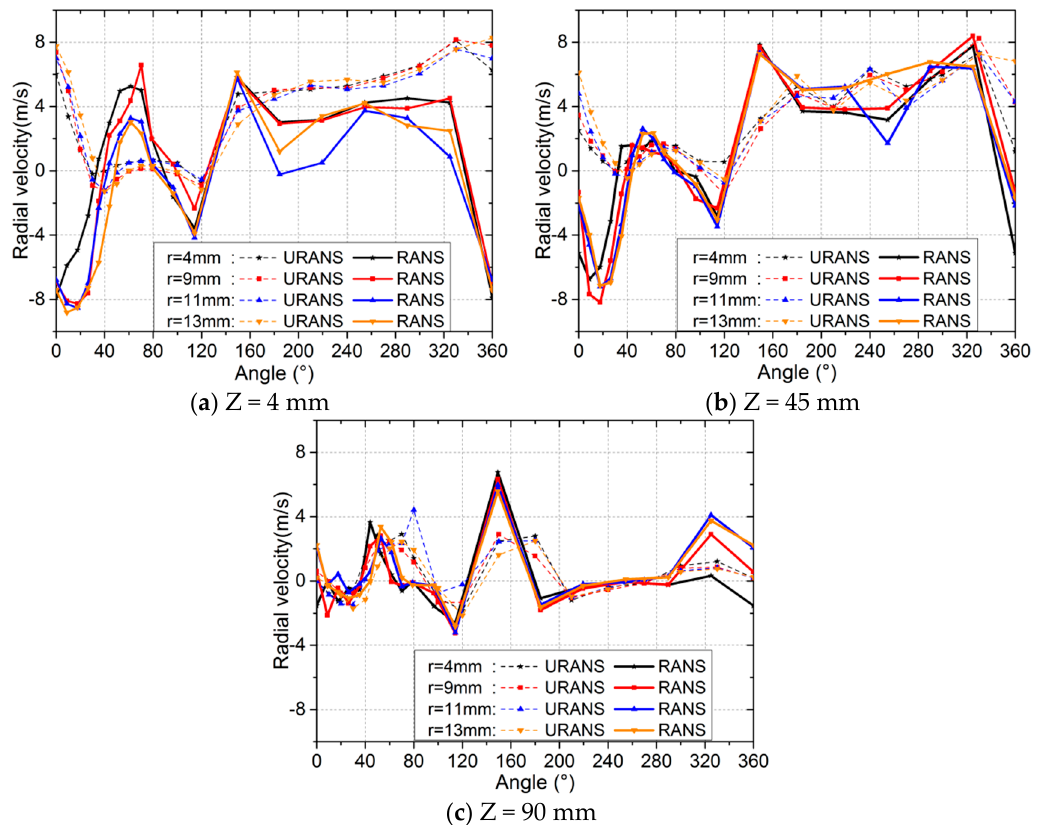
Figure 15. Variation of radial velocity within the blade passages.